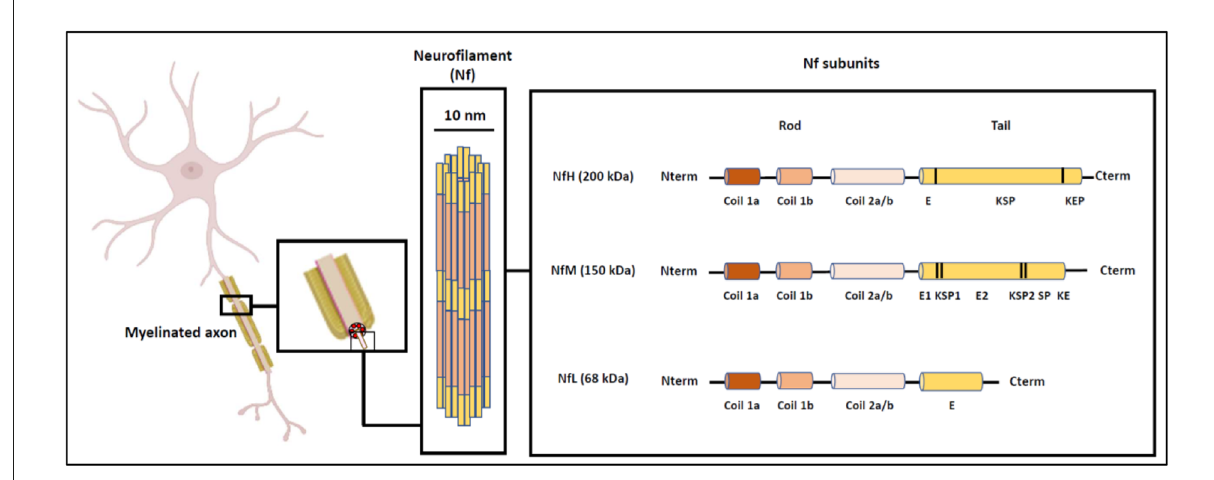
FIGURE1 Structure and organization of neurofilaments (Nf), adapted from Gaetani et al. (2019).